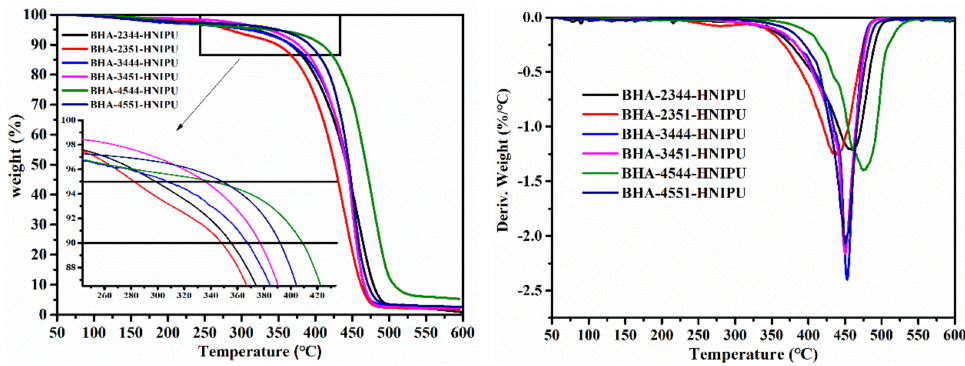
Figure 9. TGA ( left ) and DTG ( right ) curves of HNIPUs.